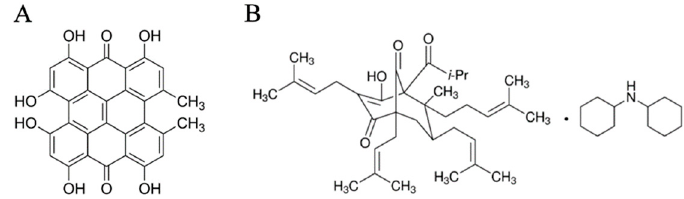
Figure 9. Structure of HY ( A ) and HP ( B ).